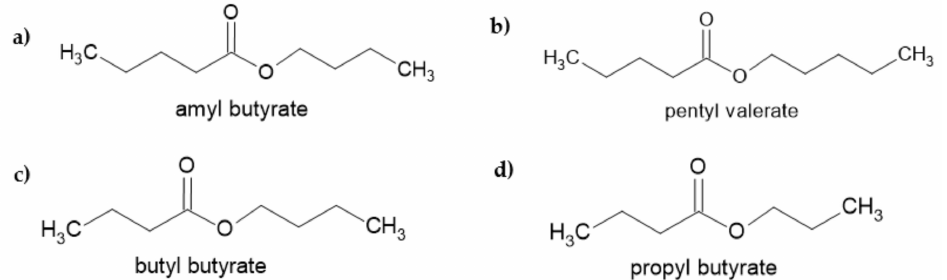
Figure 7. Structure of ( a ) amyl butyrate (target odorant), ( b ) pentyl valerate, ( c ) butyl butyrate and ( d ) propyl